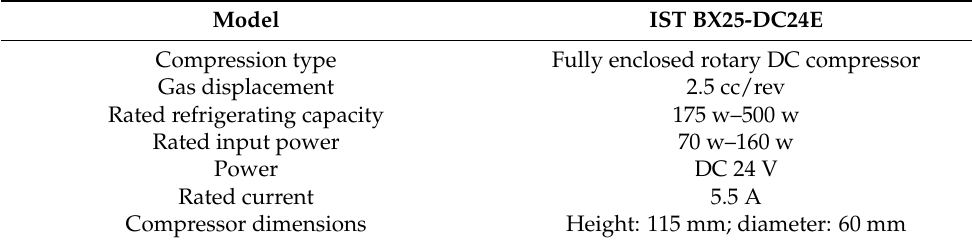
Table 4. Technical parameters of the micro refrigeration